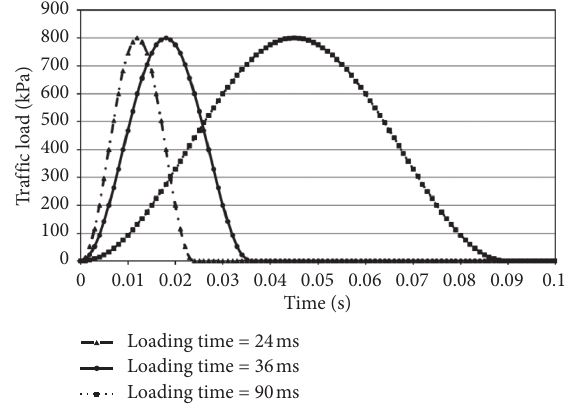
Figure 4: The loads applied in the simulations.